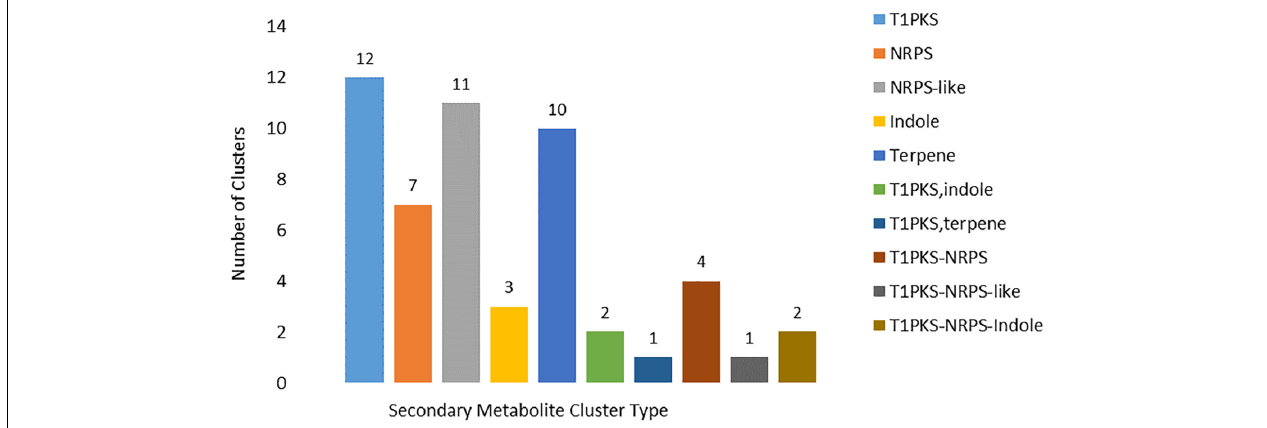
FIGURE 7 | Core biosynthesis gene types associated with the identified secondary metabolite clusters types identified (T1PKS = T1 polyketide synthase; NRPS = non-ribosomal peptide synthetase).